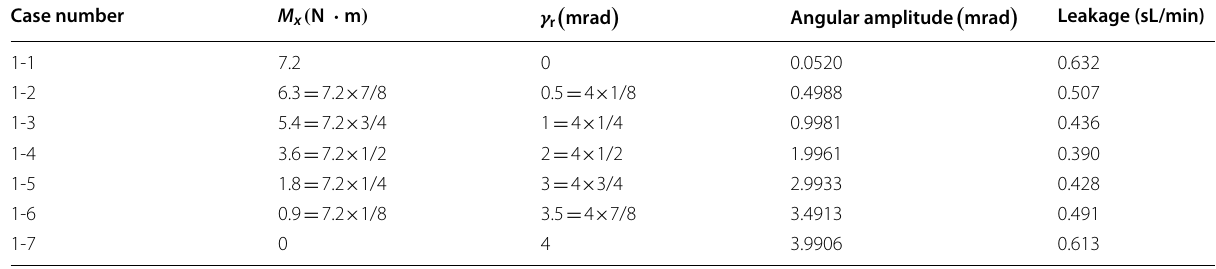
Table 2 Group 1: Mixtures of the moment on stator and the rotor tilt with varying